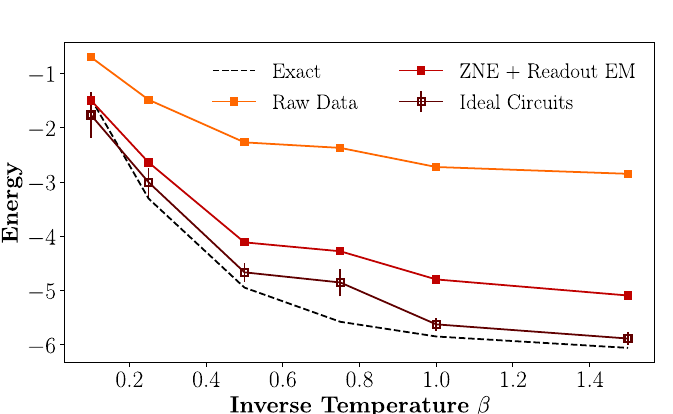
Figure 5. Thermal energy data from canonical TPQ states, as a function of inverse temperature β , of a 3-qubit 1D Heisenberg model executed on both a noiseless quantum simulator and on IBM’s “ibmq computer. The QITE algorithm was performed with 10 imaginary time-steps for each value of β . Raw hardware data is presented in comparison to results after readout error mitigation (EM) and zero-noise extrapolation (ZNE) have been applied.